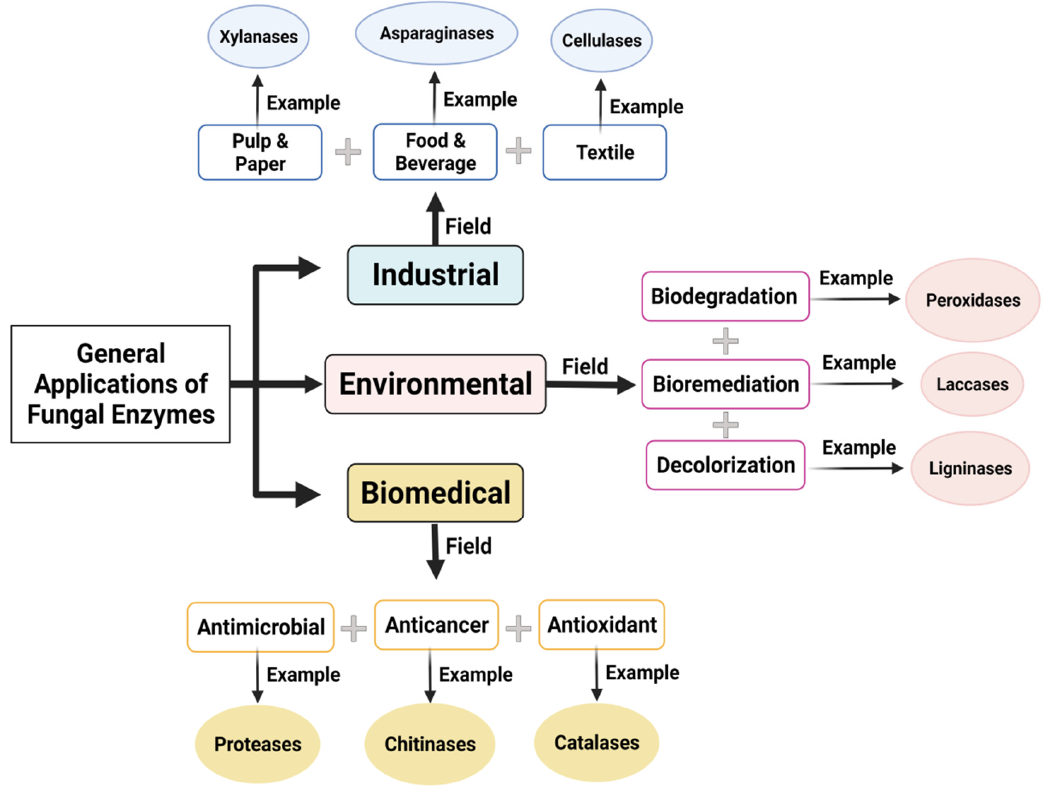
Figure 2. Schematic diagram of general application of fungal enzymes.